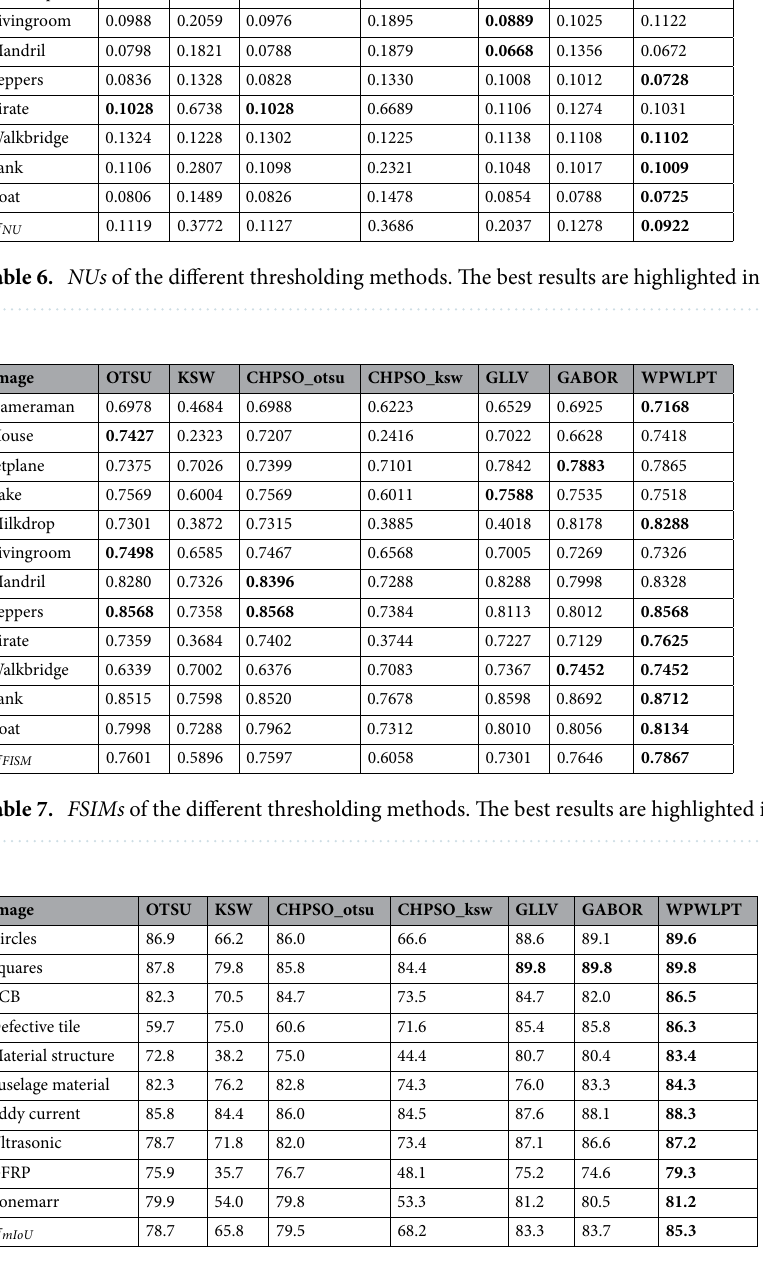
equal to 0.0034, 0.0612 and 0.8151, respectively. The ̟ ME of WPWLPT outperforms the competing methods by 0.0037 to 0.1595, the ̟ NU outperforms the competing methods by 0.0102 to 0.1484, and the ̟ FISM out- performs the competing methods by 0.0101 to 0.1636. For the eight NDT image, the ̟ ME , ̟ NU , and ̟ FISM of WPWLPT equal to 0.0386, 0.0886 and 0.7168, respectively. The ̟ ME of WPWLPT outperforms the com- peting methods by 0.0146 to 0.2152, the ̟ NU outperforms the competing methods by 0.0088 to 0.2999, and the ̟ FISM outperforms the competing methods by 0.0192 to 0.0950. For the benchmark of twelve images, the